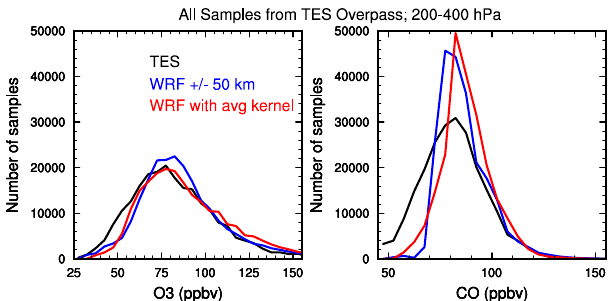
Fig. 7. Frequency distribution of O 3 (left panel) and CO (right panel) for the 200–400hPa altitudes from TES data (black line), WRF-chem results (blue line), and WRF-chem modified by the TES a priori and averaging kernel (red line) for 15 July to 6 August 2006 TES passes over the model